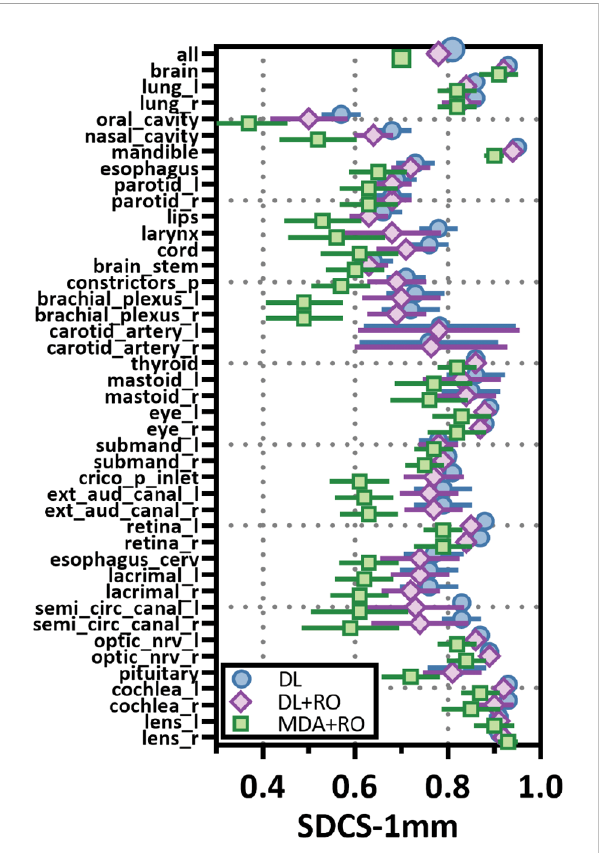
FIGURE 4 Mean surface Dice similarity coef fi cient (SDSC) with a 1mm tolerance, and 95% con fi dence intervals for the unrevised deep learning (DL), radiation oncologist (RO) revised deep learning (DL +RO), and RO-revisions to the initial MDA contours (MDA+RO), categorized by organ-at-risk type and for all OARs. OARs listed in order of decreasing